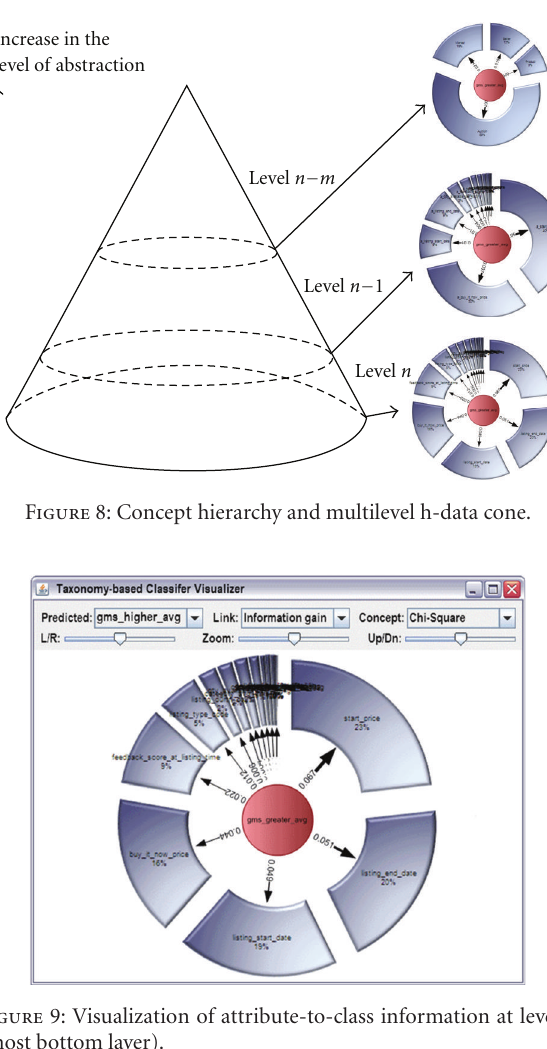
Figure 9: Visualization of attribute-to-class information at level n (most bottom layer).